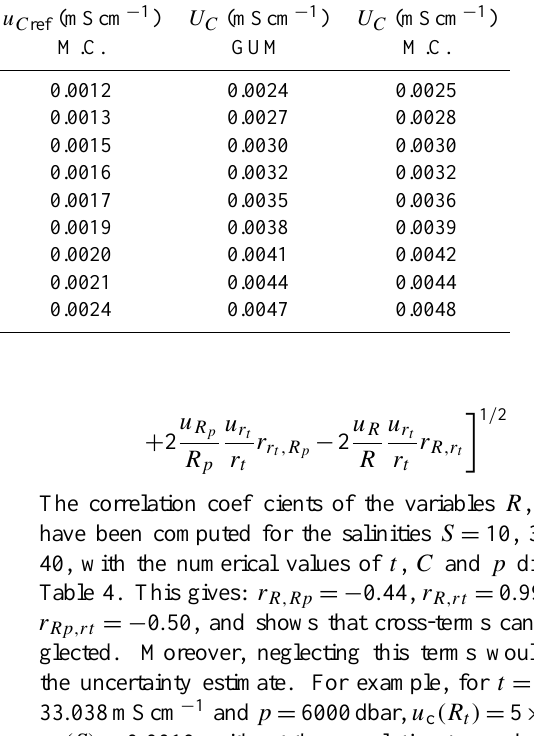
Table 4. This gives: r R,Rp = − 0 . 44, r R,rt = 0 . 998 ≈ 1 and r Rp,rt = − 0 . 50, and shows that cross-terms cannot be ne- glected. Moreover, neglecting this terms would increase the uncertainty estimate. For example, for t = 2 ◦ C, C